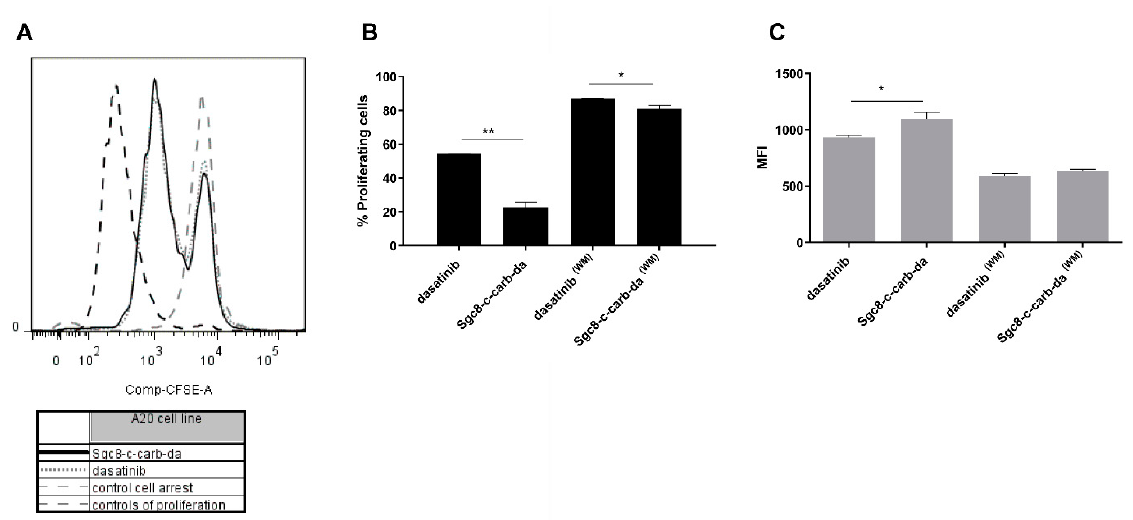
Figure 6. Arrest of cell proliferation in A20 cells after incubation with Sgc8-c-carb-da and dasatinib (800 nM) for 48 h, with (WM) or without the washing method (60 min of drug exposure followed by a wash and further incubation). ( A ) Cell proliferation histogram, controls of proliferation, and cell arrest: incubation with medium (100% proliferating cells) and 20% of DMSO (0% proliferating cells), respectively. ( B ) Percentages of proliferating cells are shown. ( C ) Mean fluorescence indices (MFI) for CFSE. Graph shows mean ± SD, n = 3 per condition. * p < 0.05, ** p < 0.01 (Student’s t -test).